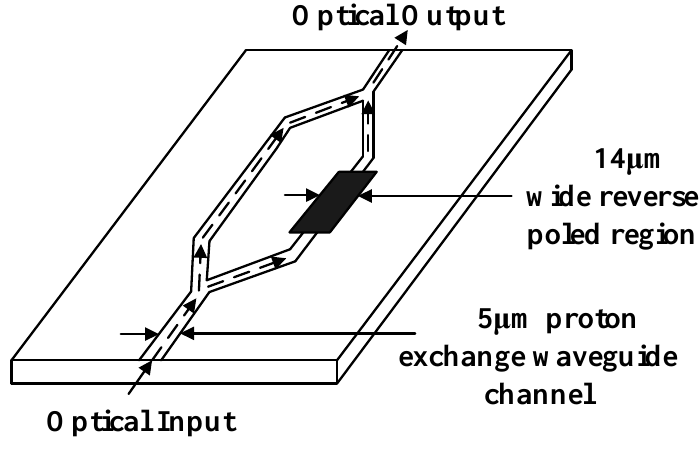
Figure 7. The domain-inversed IOES developed by the Srico Corp